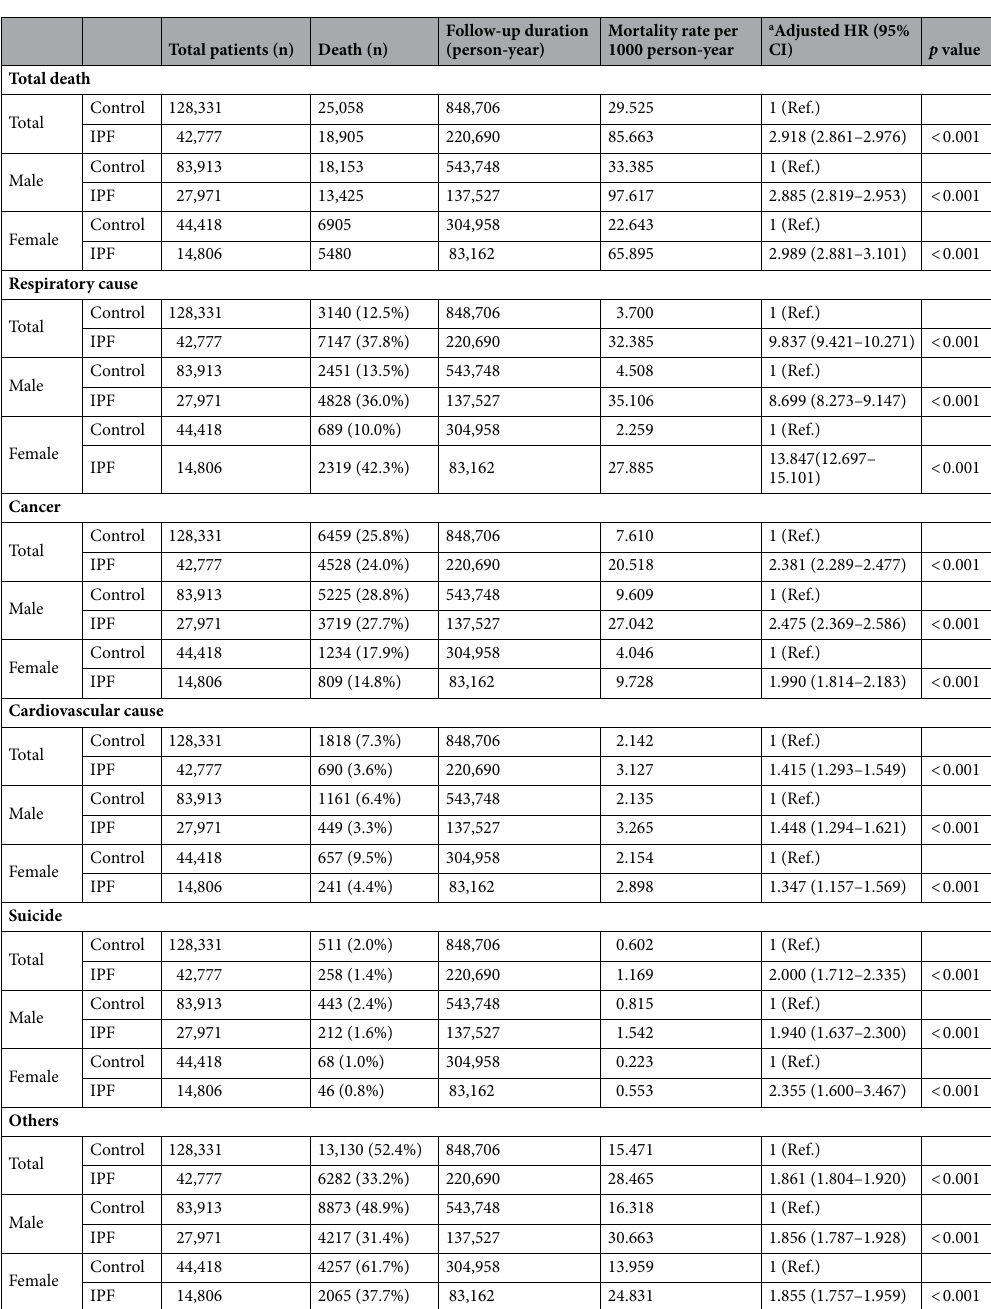
Table 2. All-cause and cause-specific mortality rates of patients with idiopathic pulmonary fibrosis (IPF). IPF idiopathic pulmonary fibrosis, HR hazard ratio, CI confidence interval, Ref reference. a Adjusted by age, sex, ischemic heart disease, stroke, cerebrovascular disease, cancer, diabetes mellitus, hypertension, dyslipidemia, liver disease, household income, and place of